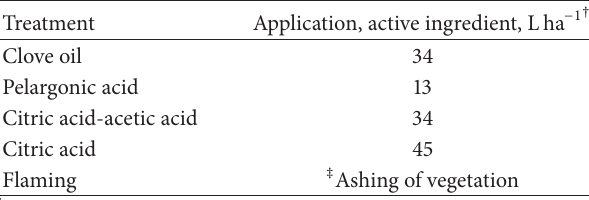
Table 2: Treatments involved in repeated applications of alternative herbicidesorflaminginfieldplotexperiments(FieldExperiment 2).